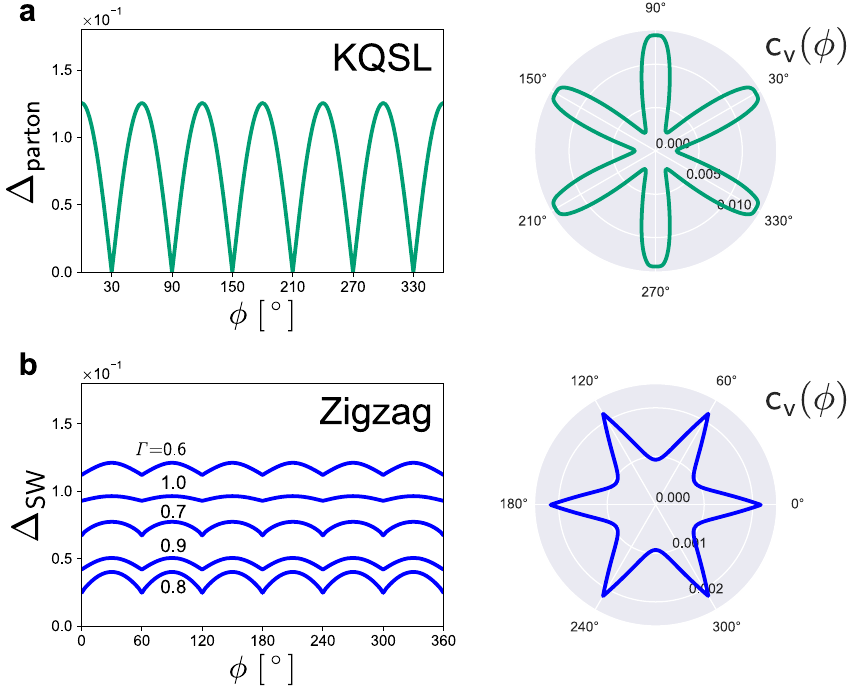
Fig. 5 Magnetic fi eld angle dependence of speci fi c heat in the KQSL and zigzag states. a KQSL state: Majorana gap Δ parton and speci fi c heat c v as functions of in-plane fi eld angle ϕ , obtained by a parton theory. b Zigzag state: magnon gap Δ SW and speci fi c heat c v as functions of in-plane fi eld angle ϕ , obtained by a spin wave theory with ð K ; Γ ; Γ 0 ; h Þ ¼ ð(cid:3) 1 ; 0 : 8 ; (cid:3) 0 : 05 ; 0 : 03 Þ & k B T ¼ 0 : 01. Magnon gaps for other values of Γ are shown together to highlight the generality of the fi eld angle